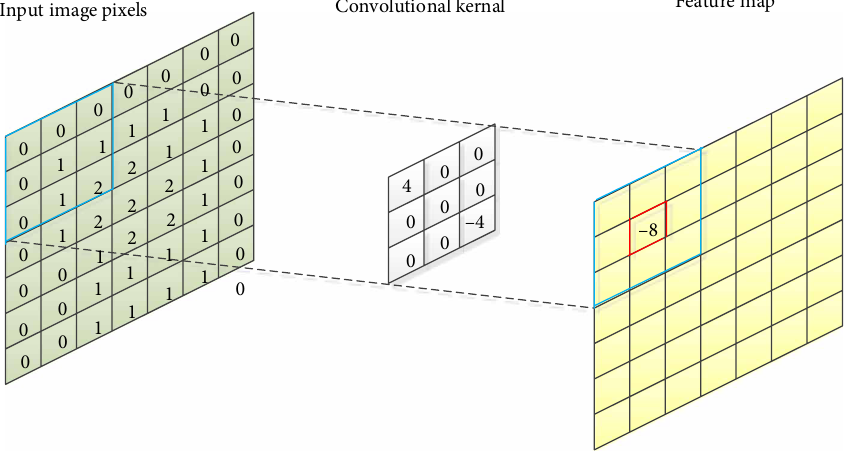
Figure 6: Convolutional operation using local connections.